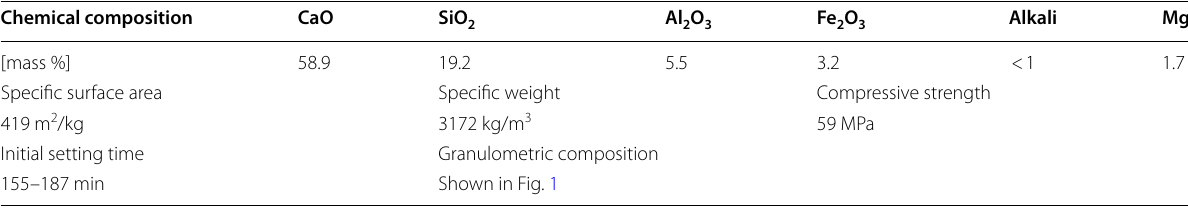
Table 2 Properties of the cement CEM II 42,5 R Chemical